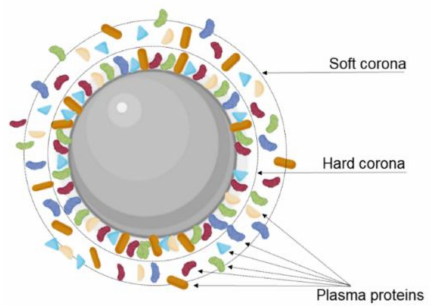
Figure 8. Schematic representation of the protein corona formed in the NPs’ surface. The protein corona is composed of a hard layer, where the proteins are more tightly associated with the NPs’ surface; and a soft layer where the proteins diffuse more